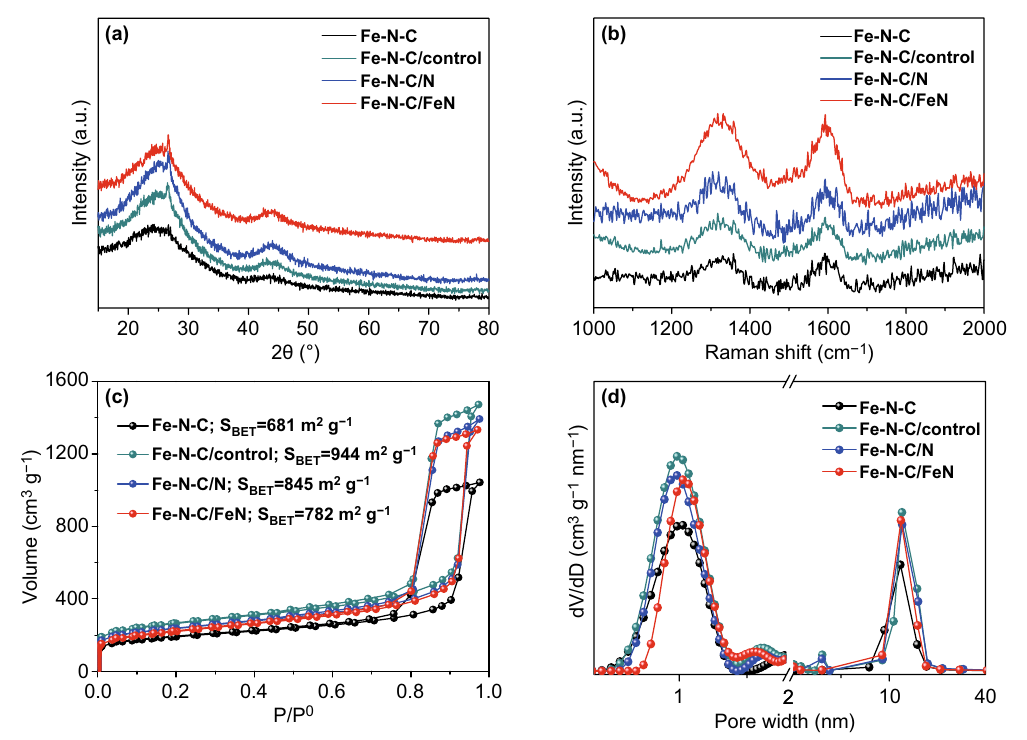
Fig. 2 a XRD patterns, b Raman spectra, c nitrogen adsorption–desorption isotherm curves and d the corresponding pore size distribution curves of the resultant